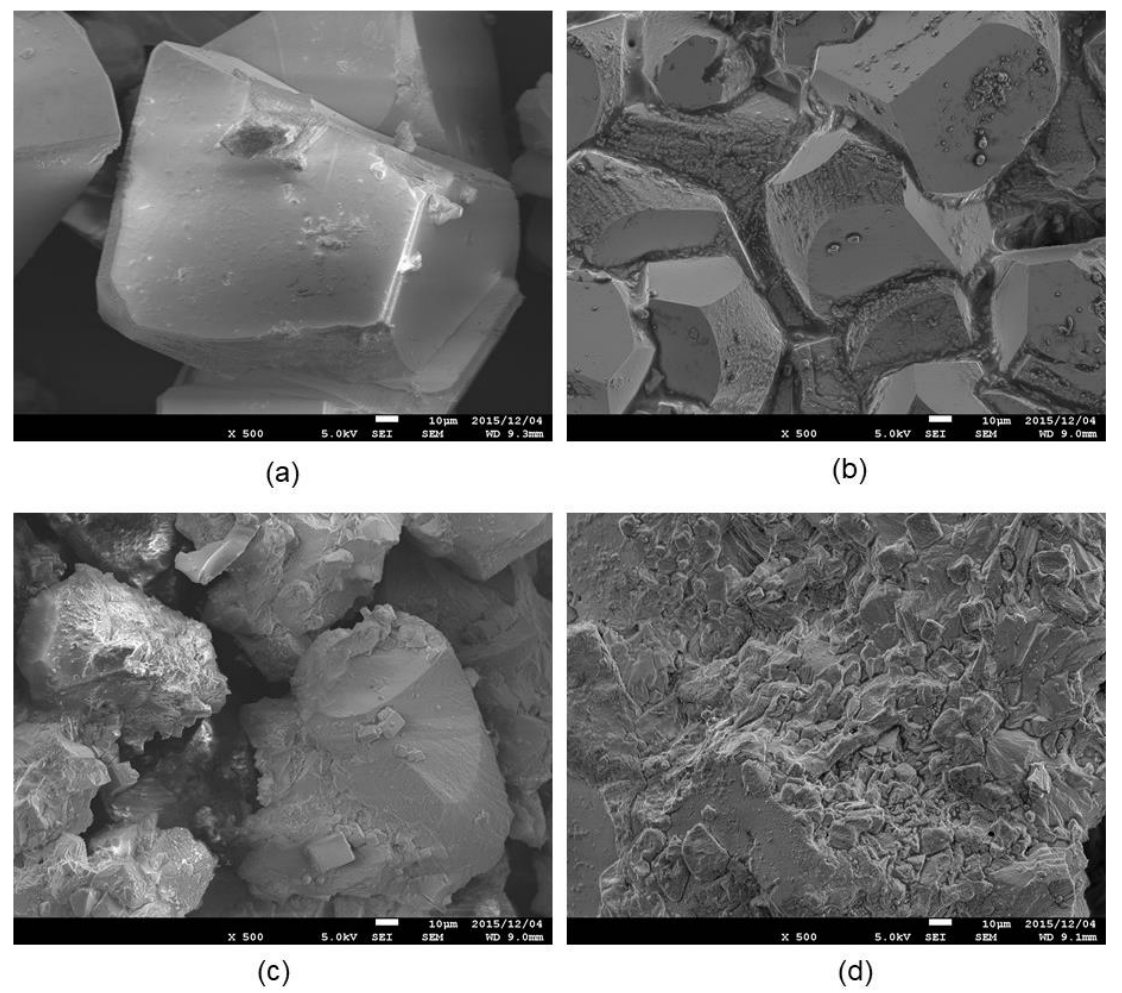
Figure 8. Evolution of calcite structure: ( a ) rhombohedral calcite (without magnesium), ( b ) addition of 10% magnesium, ( c ) addition of 20% magnesium, and ( d ) addition of 50% magnesium [19]. Putra et al. [28] also performed a SEM analysis of treated sand; the results are depicted in Figure 9a. The calcite is located on the surface and at the rounded parts of the soil particles. Simatupang et al. [26] also investigated the microstructure of treated sand using SEM. Figure 9b shows a SEM image of treated sand after treatment by an EICP solution [26]. It can be seen that the precipitated calcite is concentrated at the contact surface. The treated sand’s SEM images confirm that the precipitated calcite coated the sand particles and formed bridges between them. Al Qabany et al. [38] reported that the amount of precipitated calcite in soil depends upon the reagent of the urea-CaCl 2 concentration. With a low concentration of reagent (0.25 mol / L), the precipitated calcite is found to be distributed uniformly. In contrast, with a high concentration of reagent, the distribution of calcite is accumulated over the surface of the sand grains